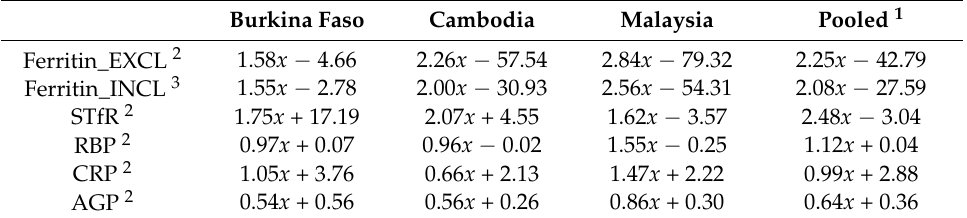
Table 4. Linear trend equations for each population group for the comparison between each of the two